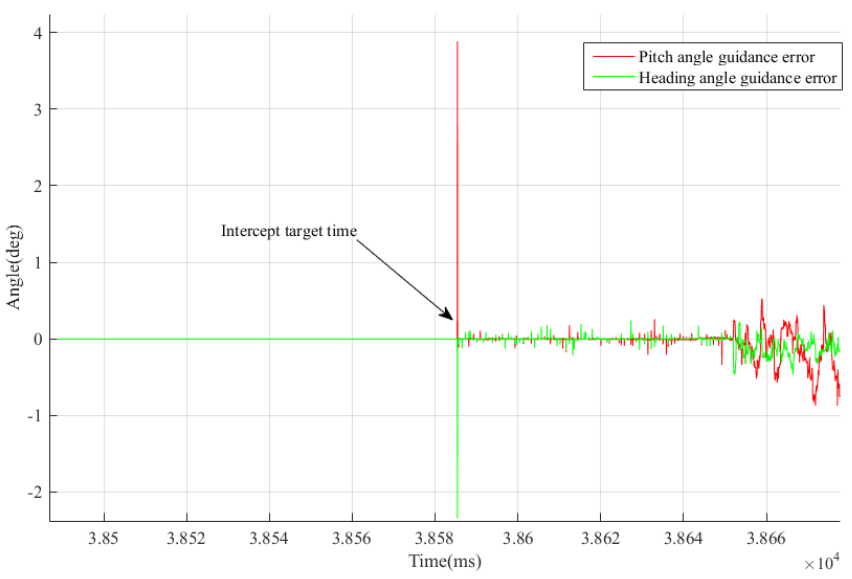
Figure 19. Accumulated errors of target interception by the radar guidance system.